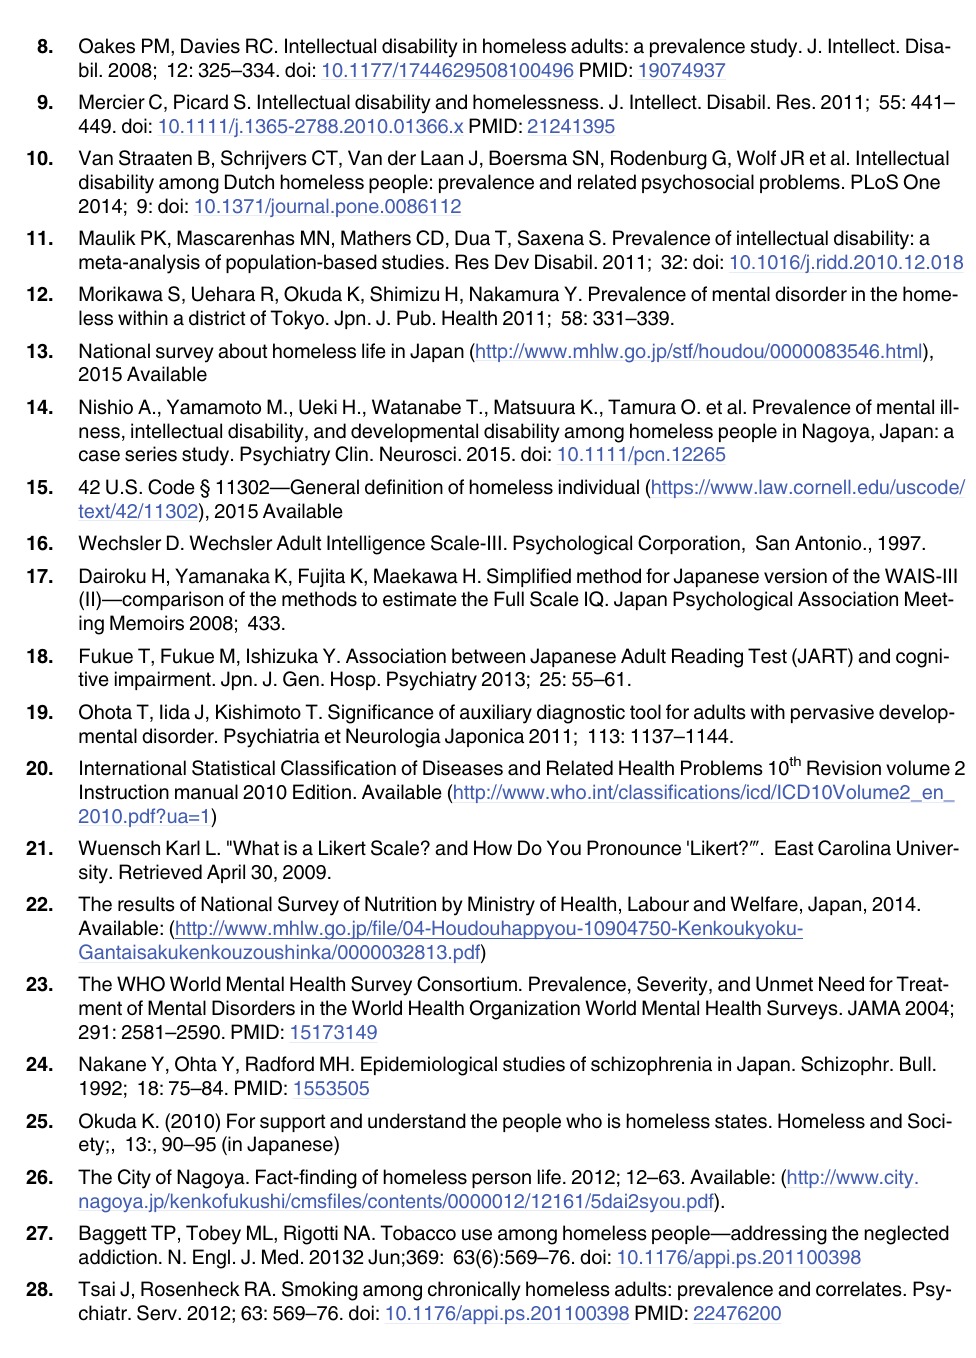
PLOS ONE | DOI:10.1371/journal.pone.0138052 September 17,